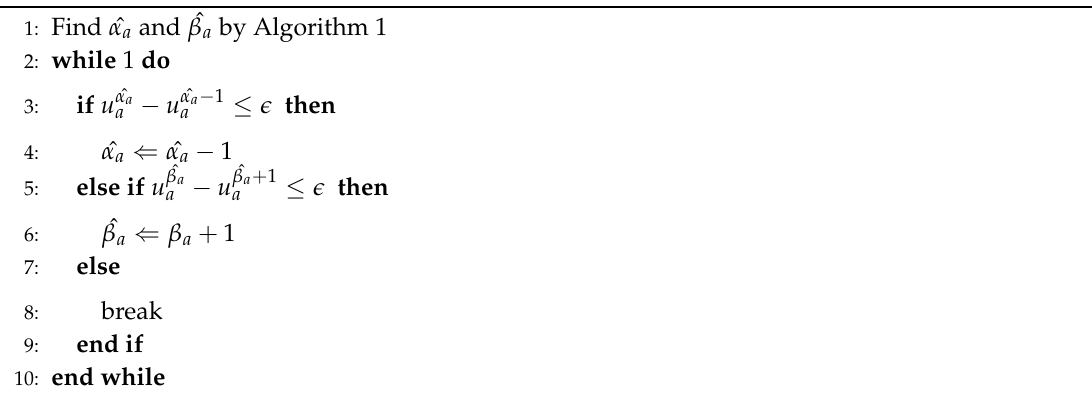
Figure 7. Example PMF of a non-interruptible appliance. Algorithm 2: Preference Searching Algorithm for Uncontrollable